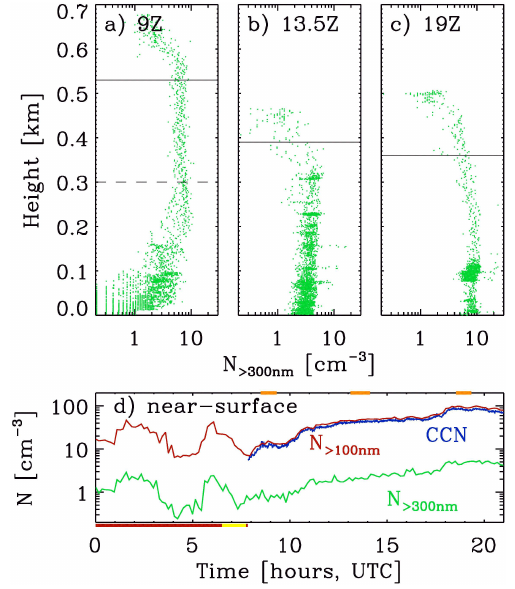
Fig. 8. Near-surface and helicopter aerosol measurements on 29 Au- gust 2008 (Case #2), including helicopter profiles of aerosol con- centration for particles larger than 300nm taken at about (a) 9Z, (b) 13.5Z, and (c) 19Z, and (d) concentrations of CCN (blue), aerosols larger than 100nm (red) and aerosols larger than 300nm (green) measured onboard Oden . In (a–c) , the solid and dashed lines are the cloud base and mixed-layer base heights determined by re- mote sensors at the time, respectively. Red bars on the lower axis of (d) indicate questionable data due to contamination (yellow bars may also be questionable due to temporal proximity), while the or- ange bars on the top axis show the times of the helicopter